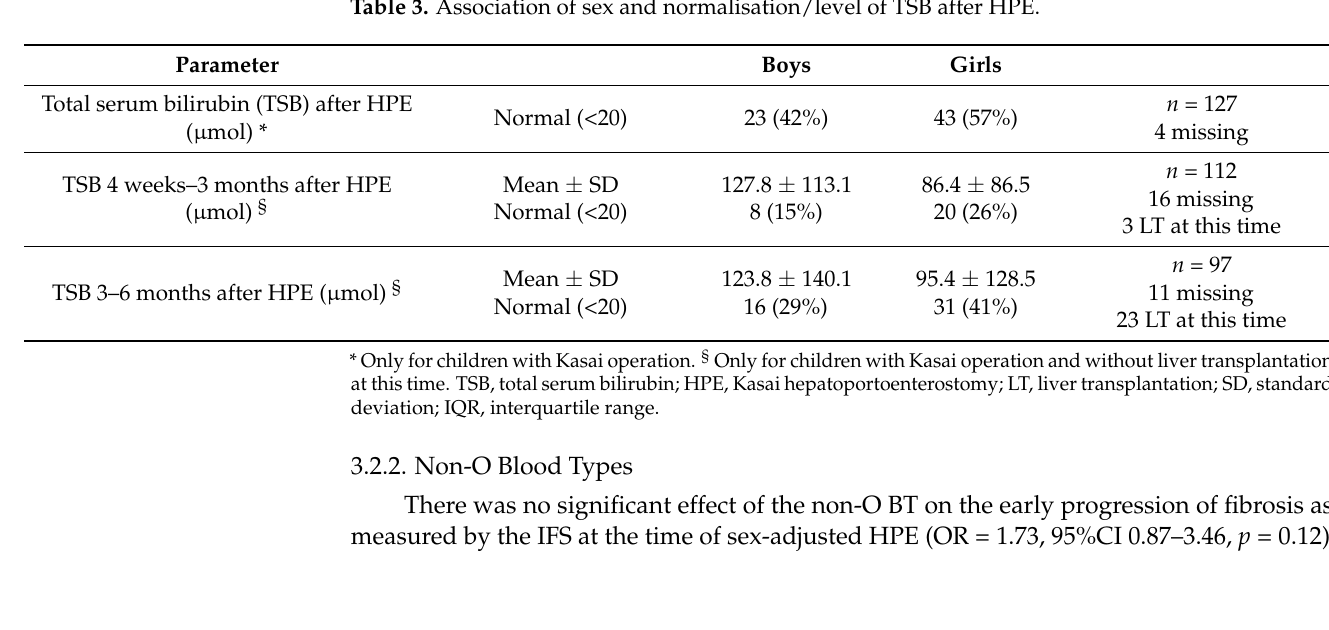
Table 3. Association of sex and normalisation/level of TSB after